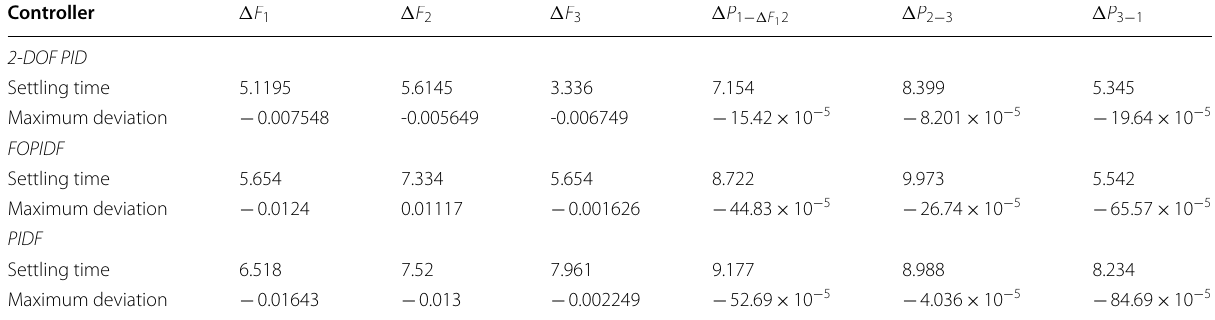
Table 3 Performance parameters of LFC with 2-DOF PID, FOPIDF, and PID controllers